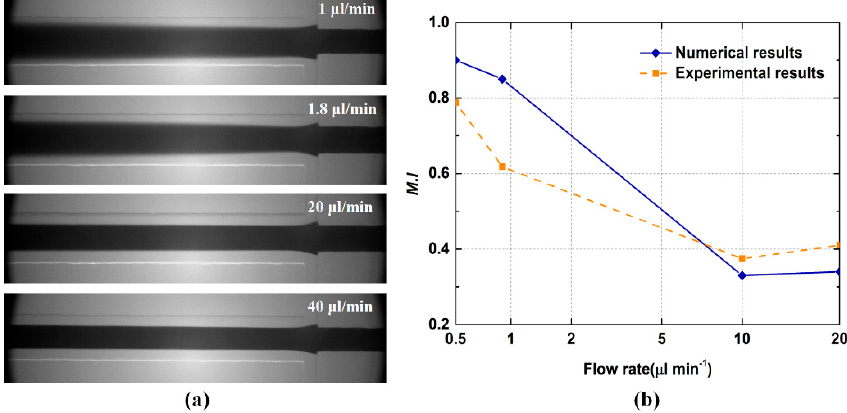
Figure 6. Model validation: ( a ) the grayscale images of the experimental process; ( b ) comparison of experimental data and simulated result of mixing index.